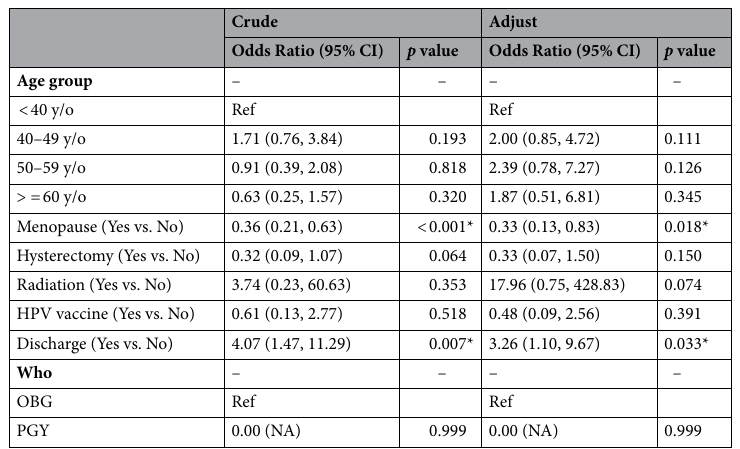
Table 2. Factors associated with unsatisfactory pap tests. ( n = 315). Data are presented as Odds ratio(95% CI). * p -value < 0.05 was considered statistically significant after test. Ref.: reference, NA: Not available. OBG: obstetrics and gynecology; PGY: postgraduate years 1 and 2.